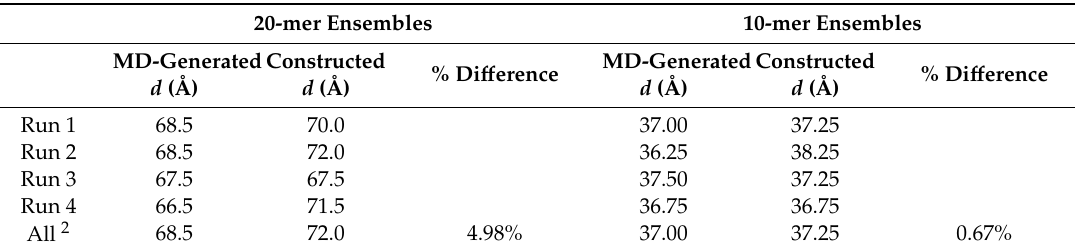
Figure 19. End-to-end distance probability distribution of MD-generated nonsulfated heparan 20-mer ensemble; each of the four runs includes 10,000 conformations; probabilities were calculated for end-to-end distances sorted into 0.5 Å bins. Table 7. Most Probable End-to-End Distances ( d ) in MD-Generated and Constructed Nonsulfated Heparan Ensembles 1